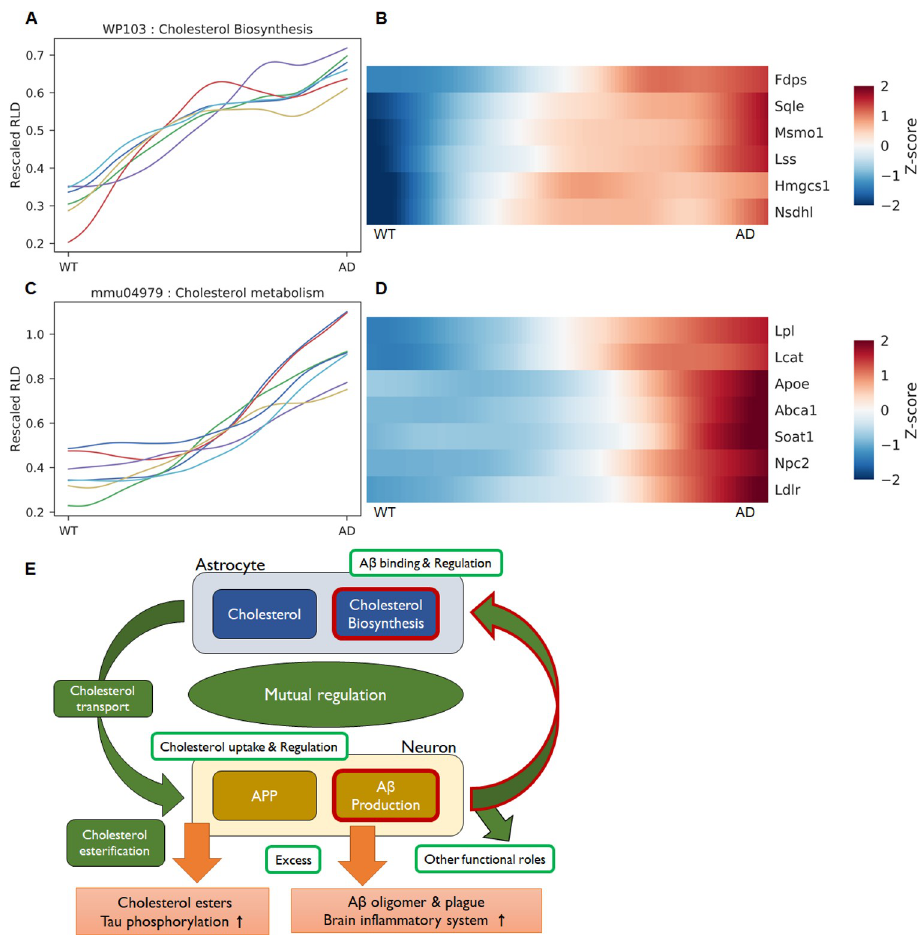
Fig 6. The transition curves and heatmap of genes related to cholesterol biosynthesis and cholesterol metabolism. (A-B) The transition curves of genes in the cholesterol biosynthesis pathway show very early increases and saturation. (C-D) Cholesterol metabolism, which is a KEGG pathway associated with cholesterol, shows a lower FDR value in P3 and a late increase of transition curves for genes such as Apoe, Abca1, and Ldlr. (E) Schematic diagram of a suggested hypothesis for mutual regulation between A β production and cholesterol biosynthesis. Our finding that A β regulates cholesterol biosynthesis is denoted by the red outlines. Other parts were constructed based on the referenced literature.